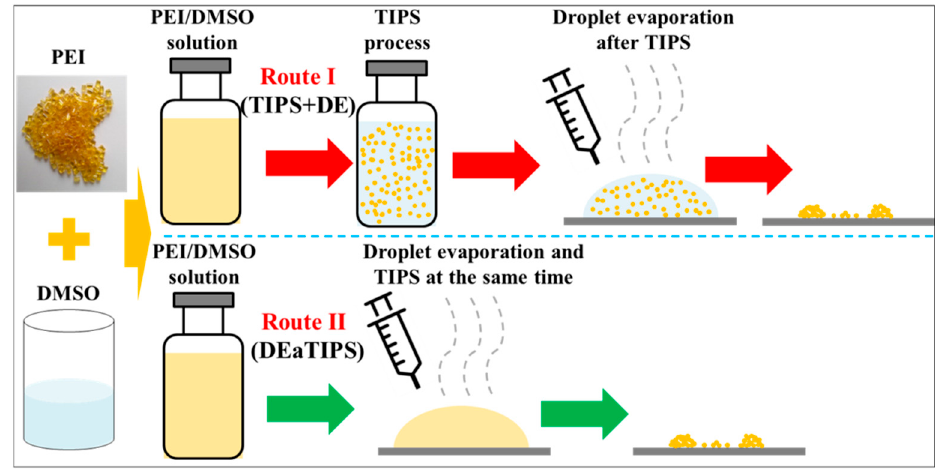
Figure 2. Schematic image of the two preparation routes.